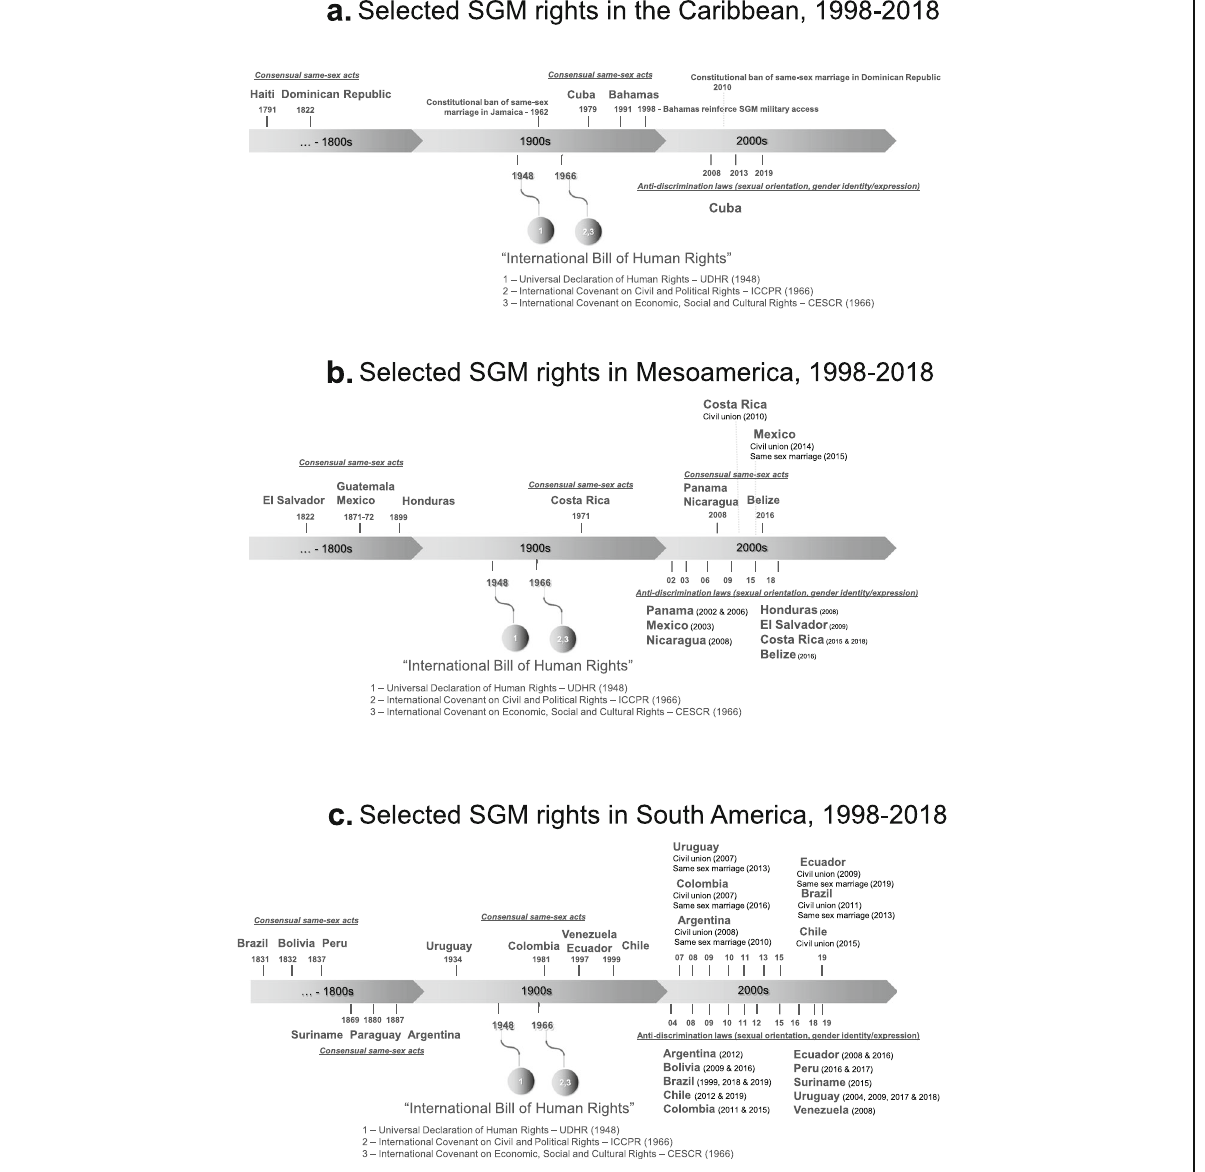
Fig. 2 a Selected SGM rights in the Caribbean, 1998-2018. b Selected SGM rights in Mesoamerica, 1998-2018. c Selected SGM rights in South America,